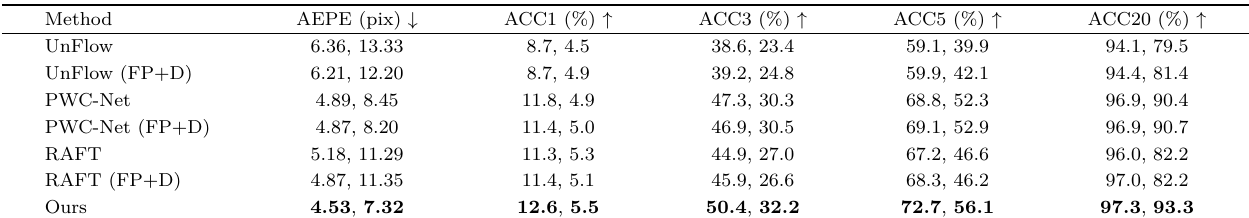
Table 4 Quantitative comparison between our method and previous unsupervised learning methods. Results on the Synthetic Face and FaceFlowData datasets are separated with commas. AEPE: average end-point-error, lower is better. For ACC1–ACC20, higher is better. FP+D: model trained using face parsing and depth priors. Best results are highlighted in bold